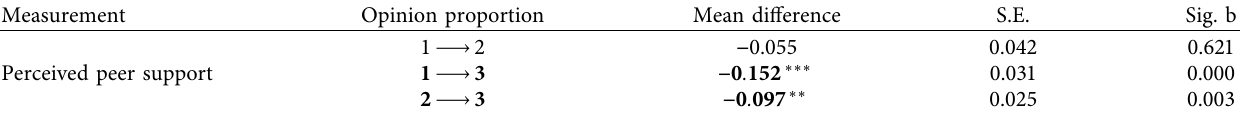
Table 3: Pairwise comparison of manipulating the level of perceived peer